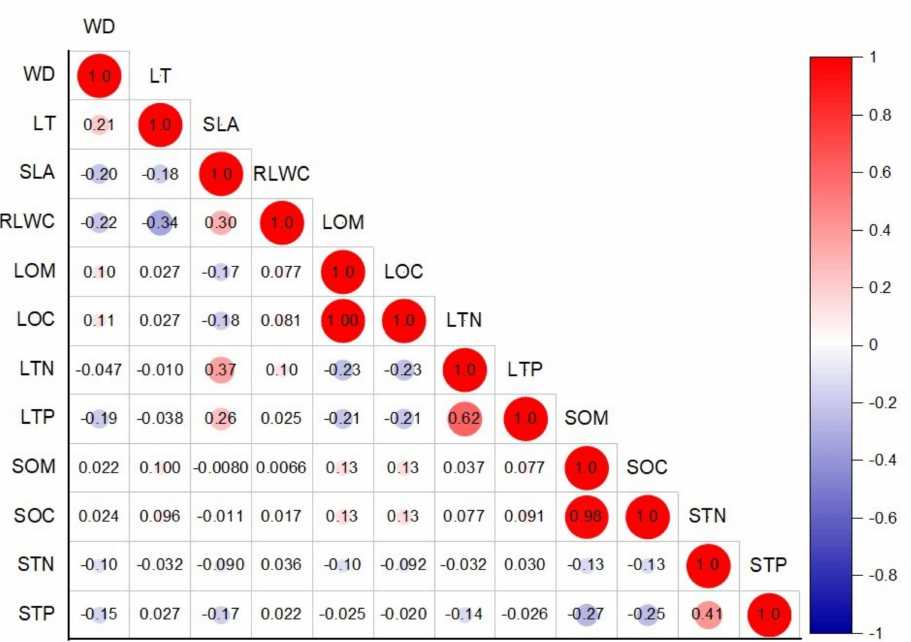
Figure 3. Pearson correlation coefficients of 12 plant functional traits within various components.